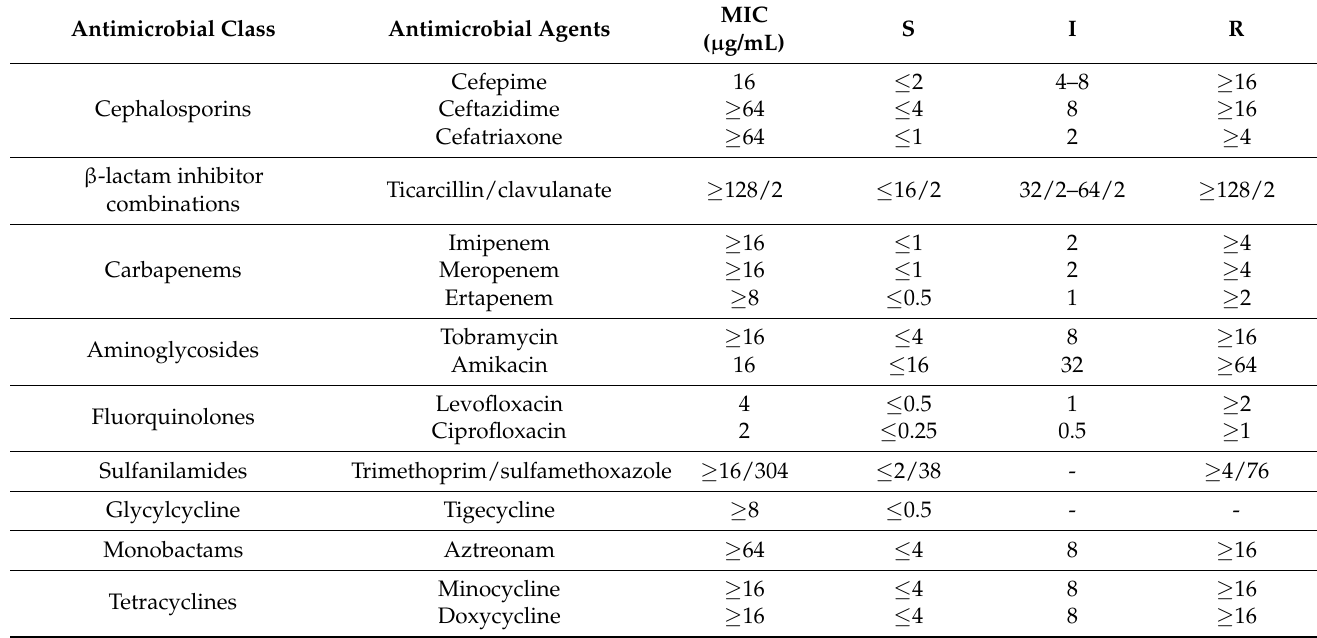
Table 1. Antimicrobial susceptibility of S. marcescens YL4